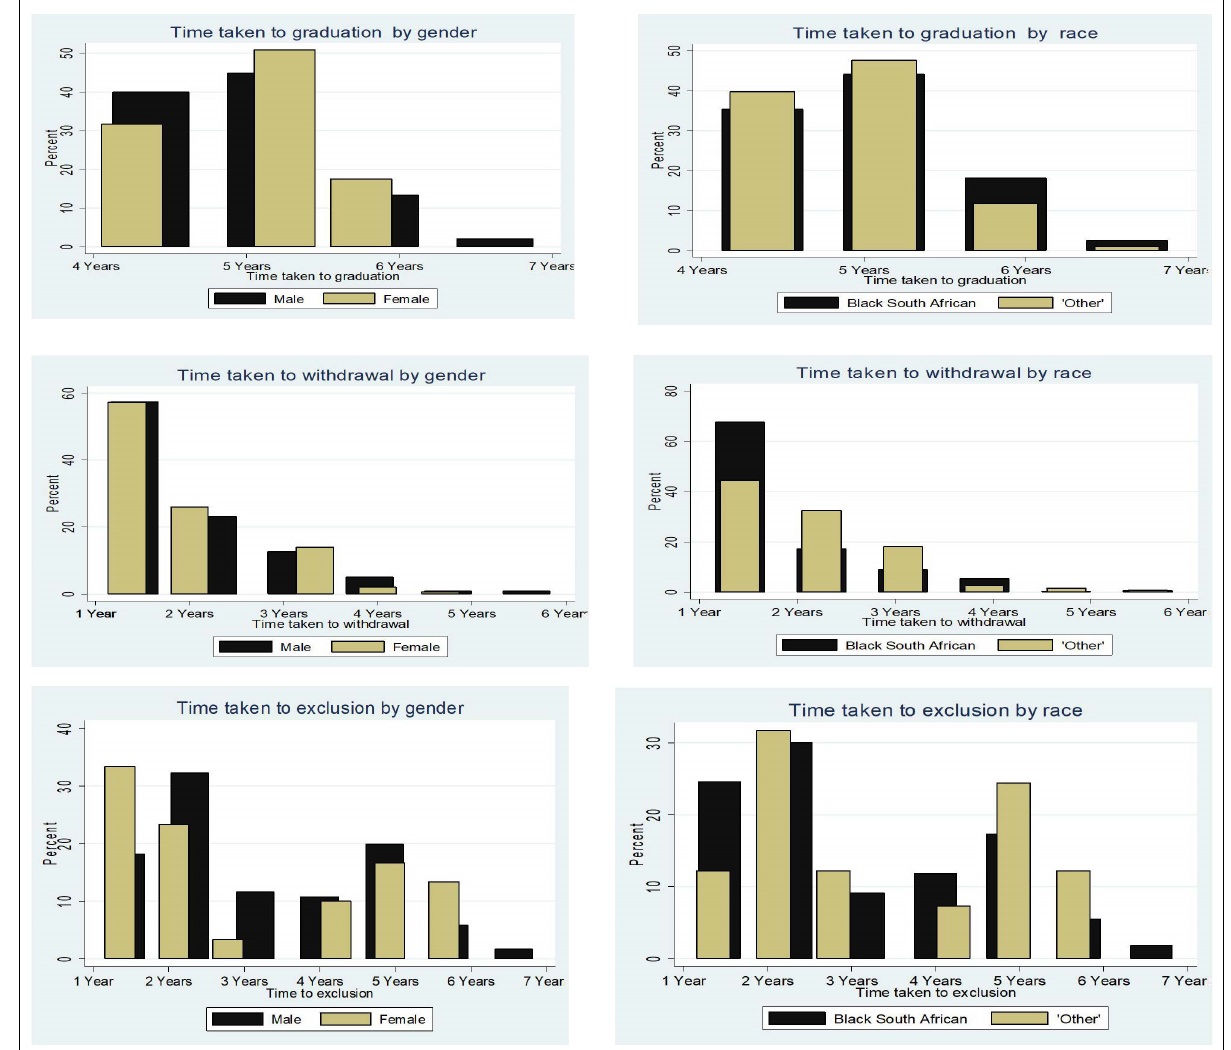
Note: Category ‘withdrawn’ includes students who either switched to other qualifications or left the university. Figure 2: Two-way histograms for graduation (persistence), withdrawal and exclusion from the engineering major.